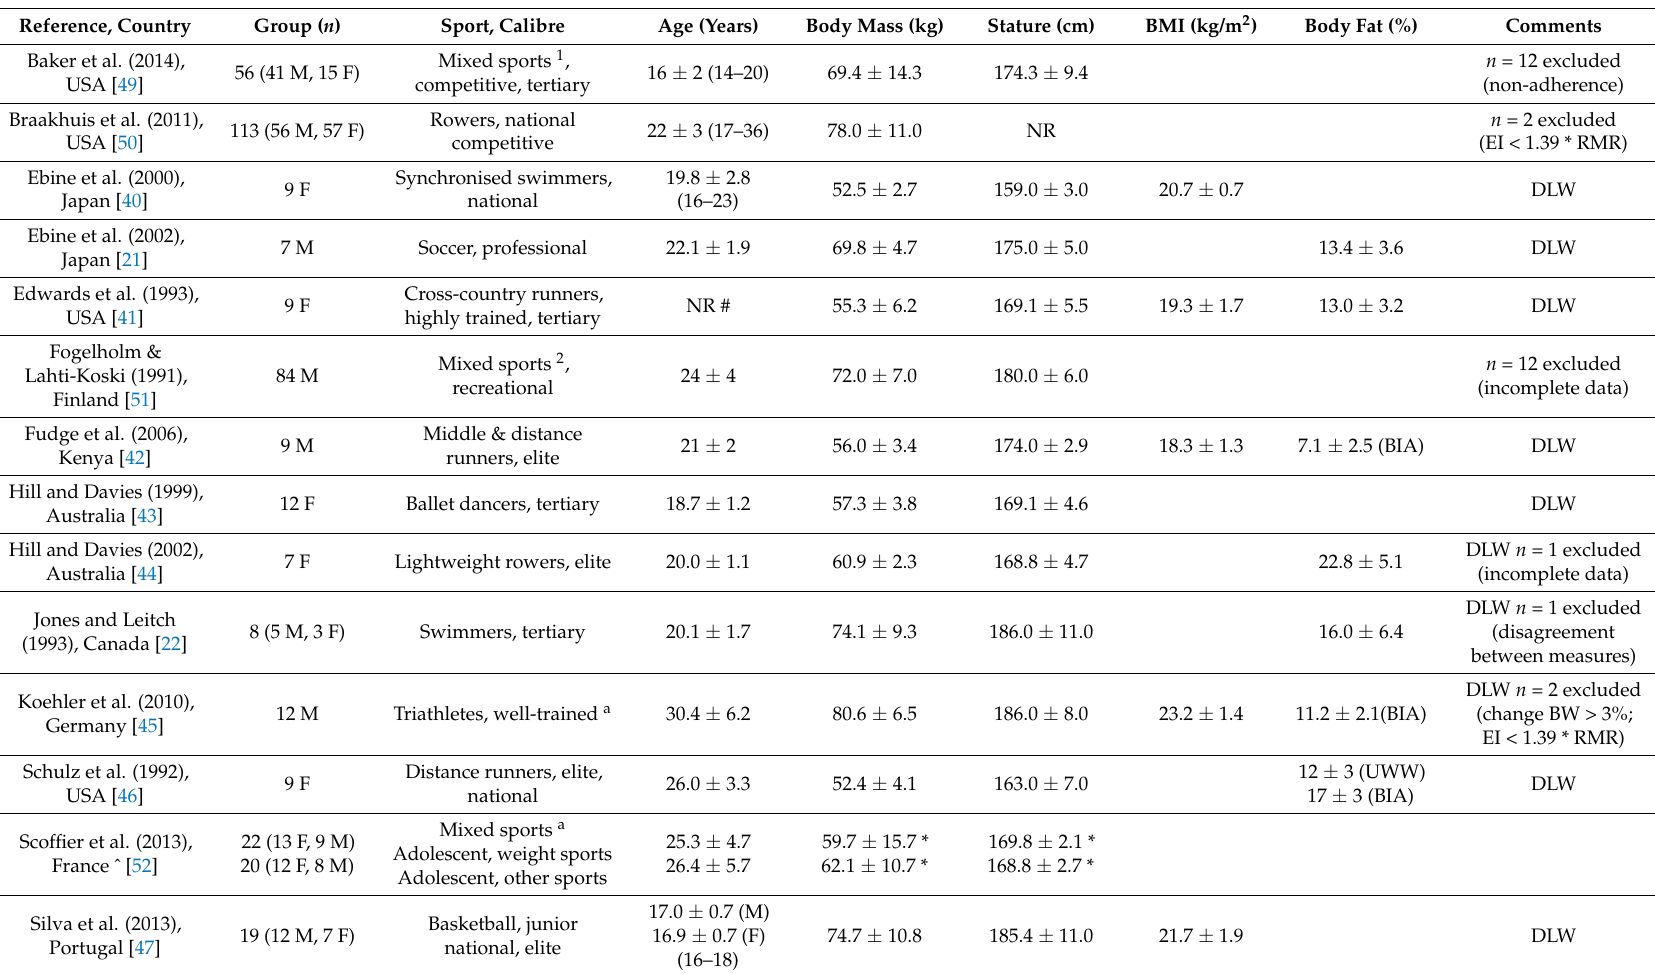
Table 1. Participant characteristics of athletes from included